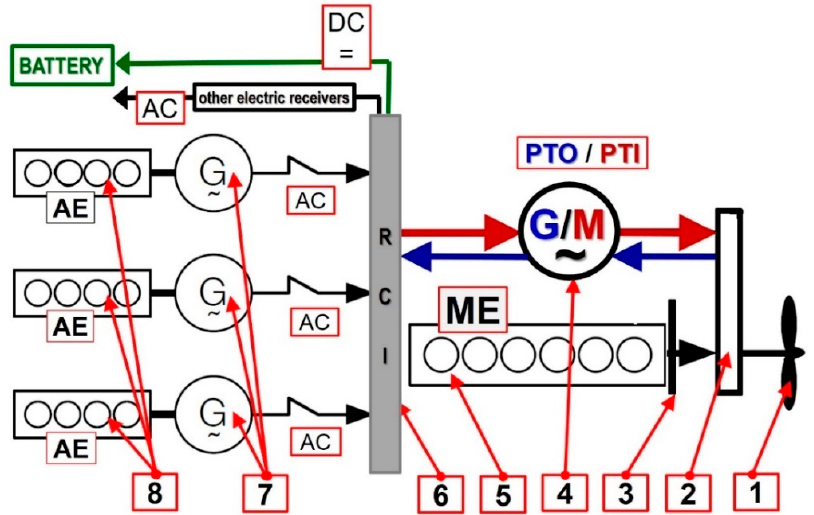
Figure 1. Example of the main propulsion system of the vessel: 1. Unregulated pitch drive screw propeller (fixed pitch propellers—FPP); 2. Electricity generator gearbox; 3. Clutch disconnector; 4. Shafted alternator (PTO/PTI); 5. Marine low-speed, two-stroke main engine (ME); 6. RCI main power unit (AC/DC rectifier, AC/AC converter, DC/AC inverter); 7. Auxiliary engine (AE)—driven generators (G); 8. Auxiliary engine (AE) driving generators of ship power plants.